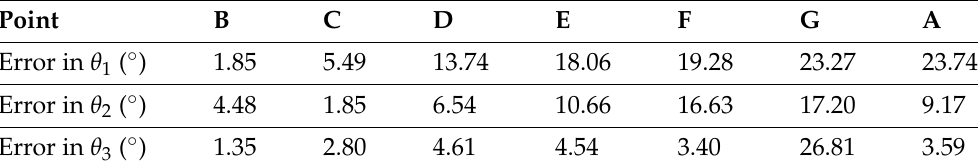
Table 5. Error of the angles of the joints during the accuracy test for the link model.